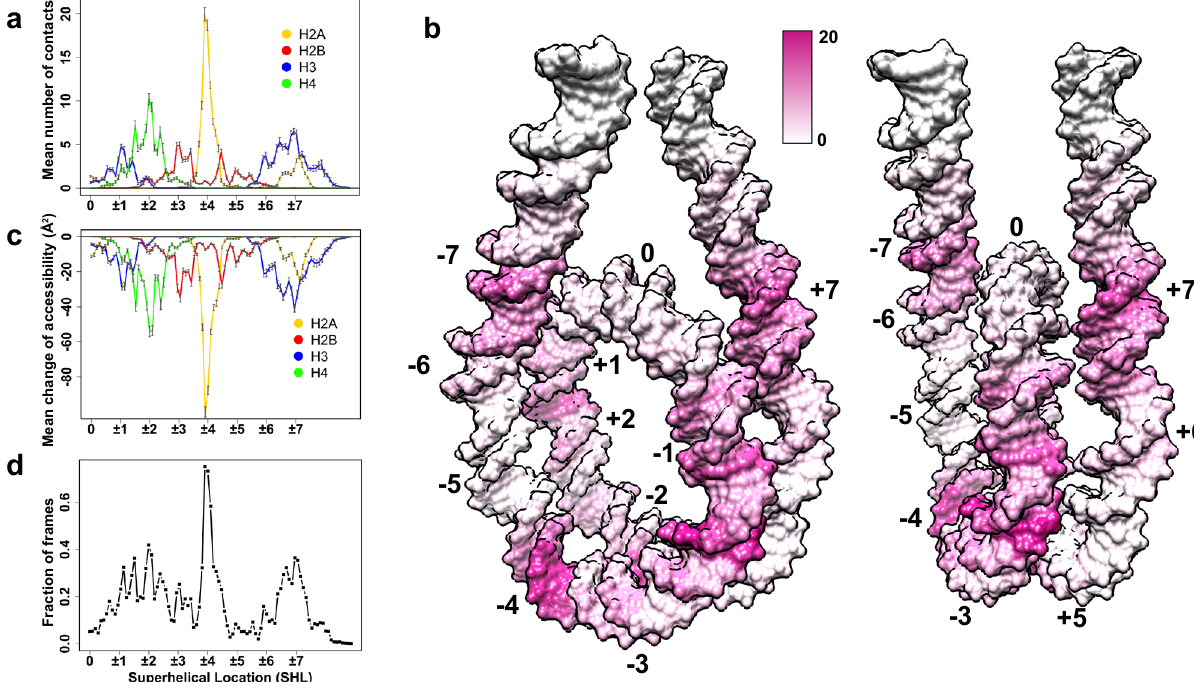
Fig. 2 Nucleosomal and linker DNA solvent accessibility modulated by histone tail binding. a A mean number of contacts between histone tails and nucleosomal/linker DNA averaged over all independent simulation runs for two copies ( n = 44) plotted in the DNA coordinate frame, zero corresponds to the dyad position and superhelical locations (SHL) are shown as integers; a combined conformational ensemble from both copies of histone tails is shown. The error bars represent standard errors of the mean calculated from independent simulation runs. b Mean number of contacts between histone tails and DNA mapped onto the molecular surface of the nucleosomal and linker DNA. c Mean values of changes of DNA solvent accessibility imposed by tail binding. The error bars represent standard errors of the mean calculated from independent simulation runs for two copies ( n = 44). d Percentage of frames with more than 20% SASA decrease upon tail binding per DNA base pair. Source data are provided as a Source Data fi